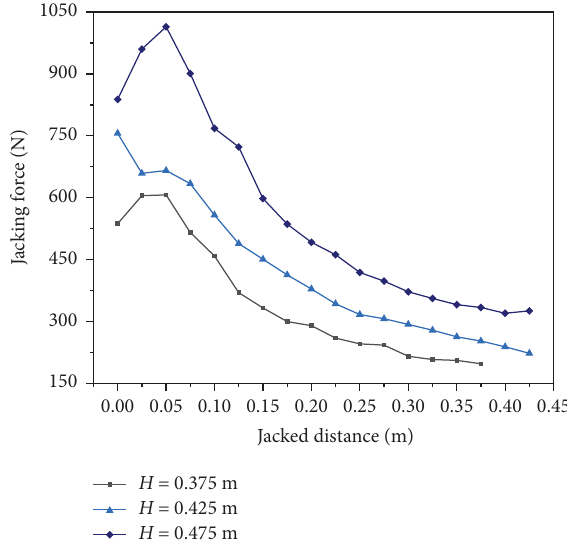
Figure 12: Infuence of height of overburden soil on jacking